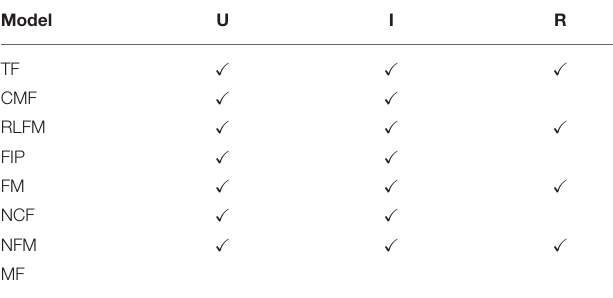
TABLE 6 | Attribute types that are used for each